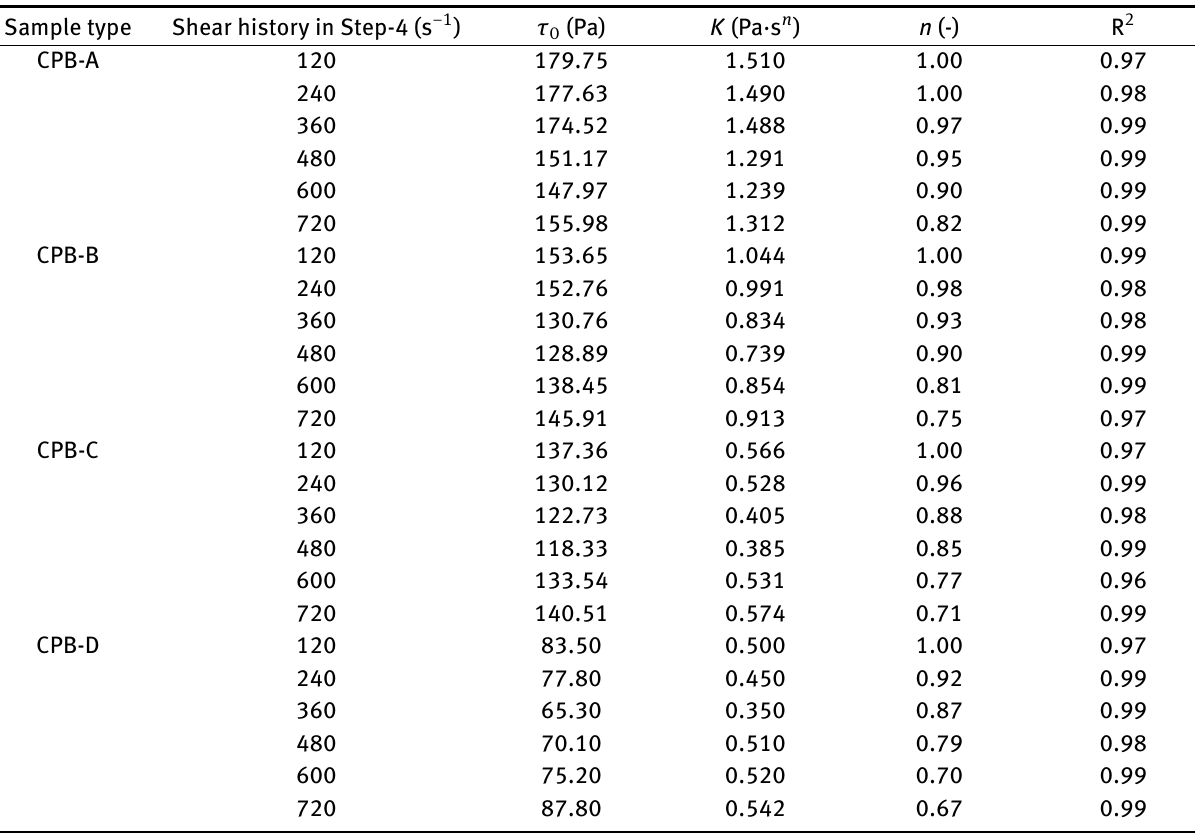
Table 4: Influence of different shear histories on Herschel-Bulkley model parameters for CPB. Sample type